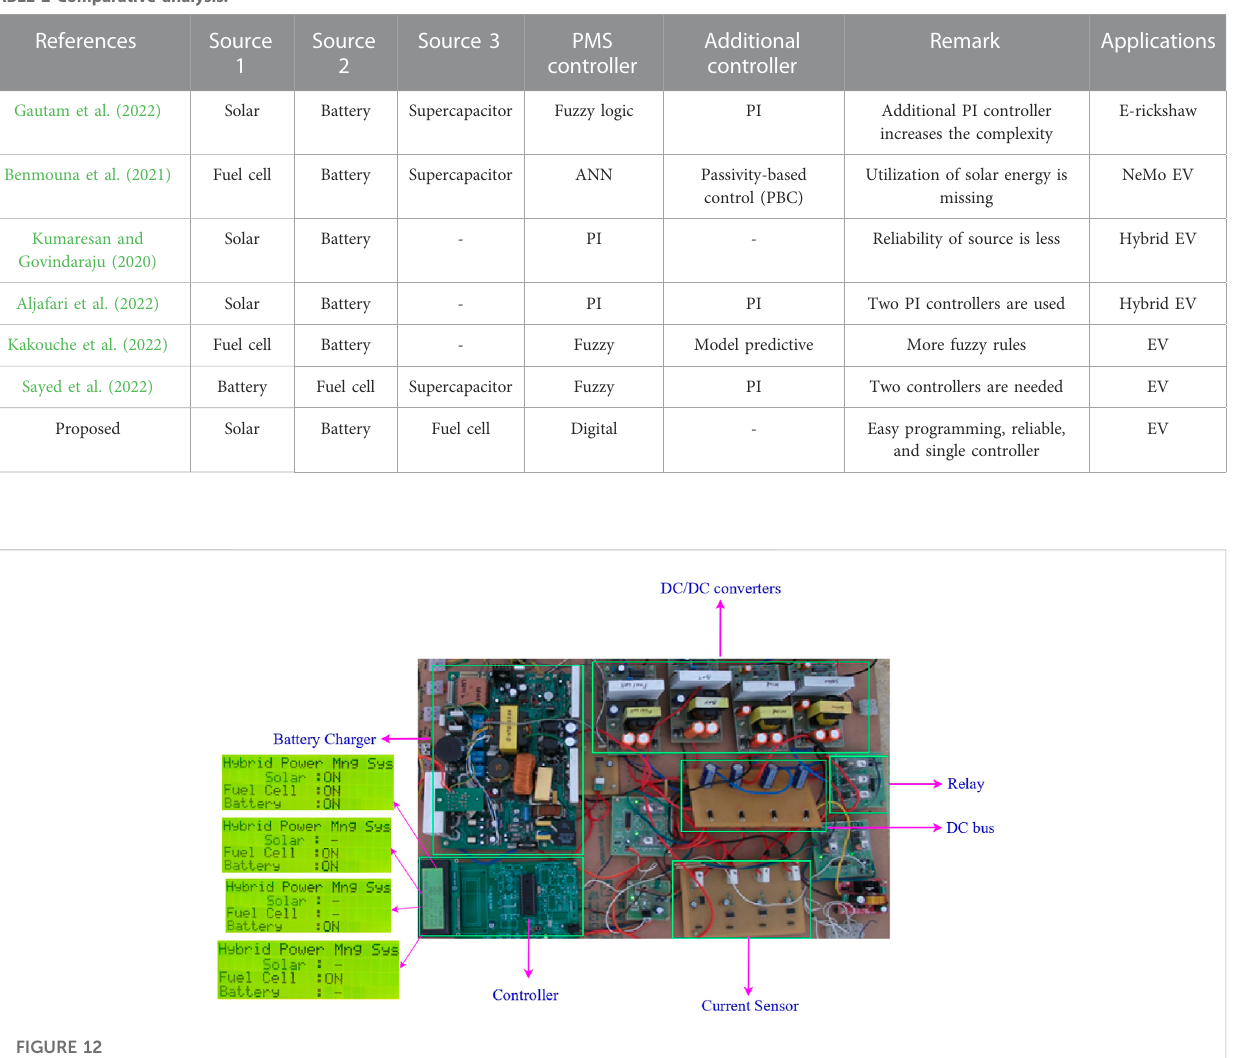
TABLE 2 Comparative analysis.